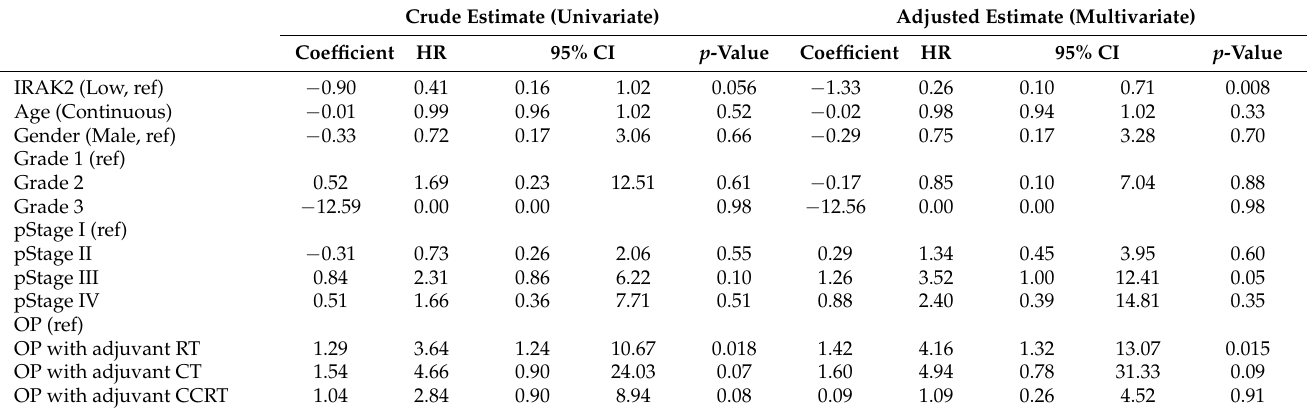
Table 3. Univariate (crude) and multivariate (adjusted) logistic regression analysis.